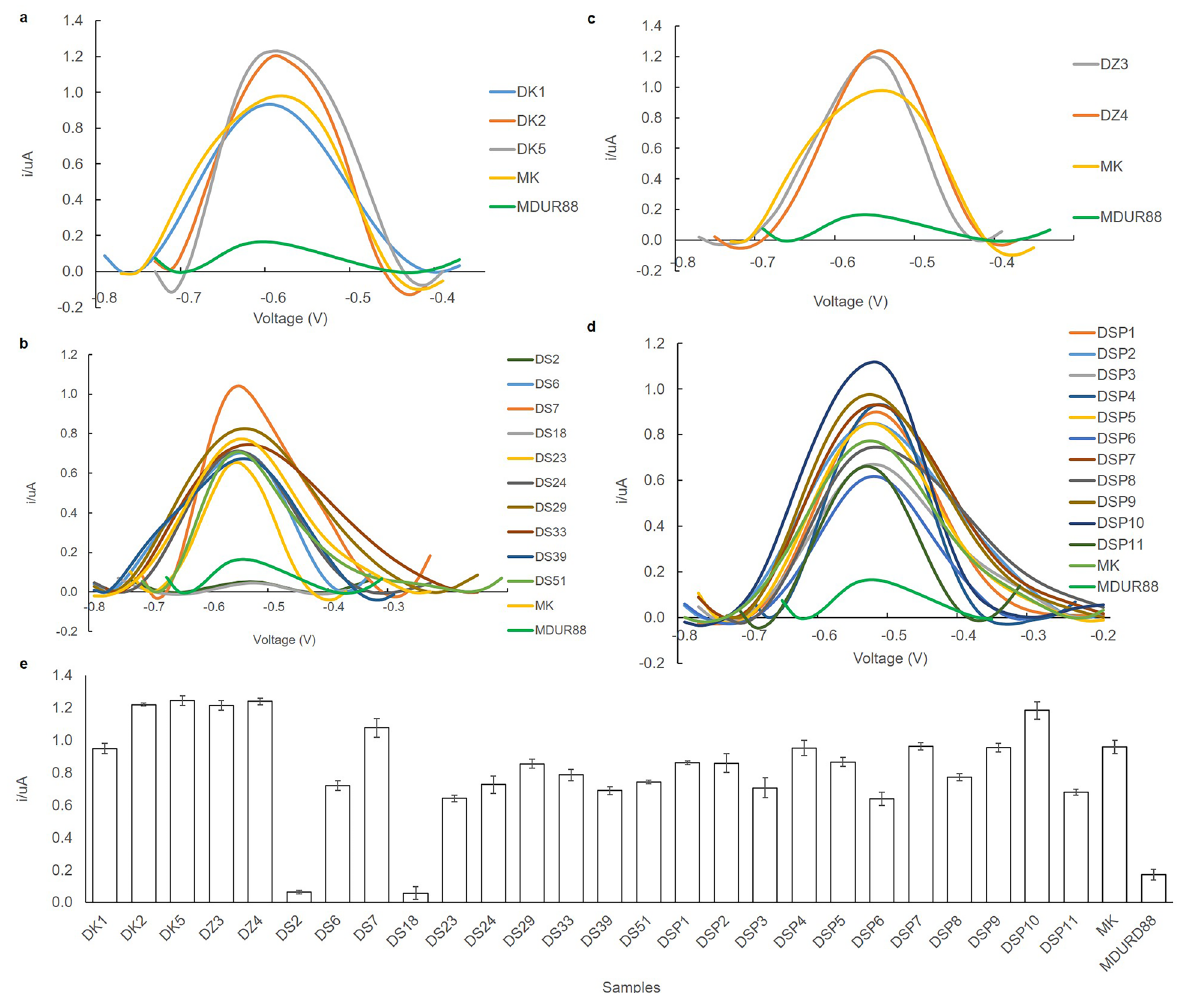
Figure 5. Typical DPV responses of the biosensor to 27 durian field samples which comprised five different locations (DK1 and DK5 from Pulau Raya, Kelantan; DK2 from Batang Merbau, Kelantan ( a ); DS2, DS6, DS23, DS18, DS51, DS59, DS39, DS24, and DS29 from Sintok, Kedah ( b ); DZ3, DZ4, and DZ6 from Zamri Agrofarm, Pahang ( c ); DSP1, DSP2, DSP3, DSP4, SP5, DSP6, DSP7, DSP8, DSP9, and DSP11 from Sungai Petani, Kedah ( d ) and the histogram of the biosensor to the field samples ( e ). MK standard was the positive control, and MDUR88 was the negative control in this study. The DPV peak rate was observed at − 0.55 to − 0.45 V/s versus Ag/AgCl reference electrode in the presence of 10 mM AQMS. Error bars are standard deviations across three repetitive